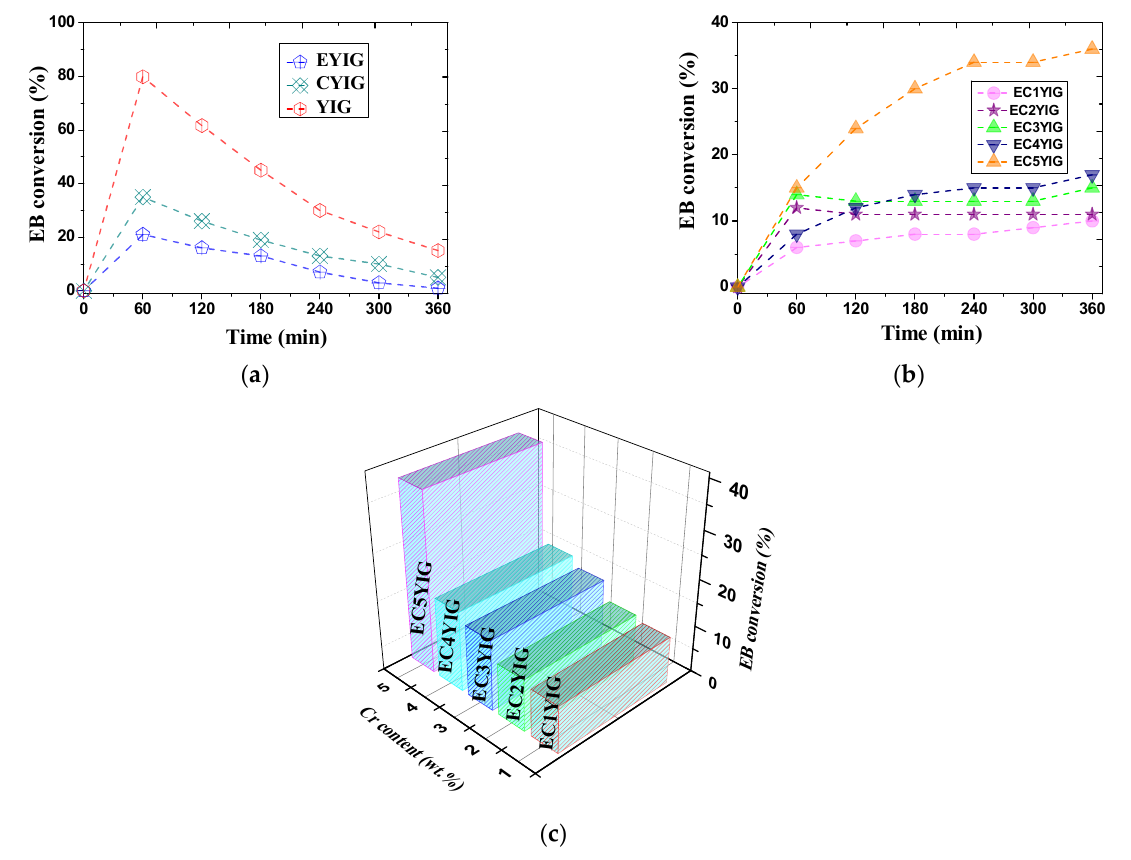
Figure 2. The reaction time-dependence conversion for yttrium iron garnet ferrites in the oxidation of ethylbenzene with H 2 O 2 : ( a ) YIG, CYIG and ECYIG catalysts ( b ) ECYIG series of garnets with distinct amounts of chromium ( c ) The relationship between EB conversions and Cr content present in the yttrium iron garnet ferrites in ethylbenzene oxidation with H 2 O 2 . Reaction conditions: EB to H 2 O 2 molar ratio of 1 using 1.3 mol of acetone as solvent, temperature of 50 °C and a catalyst mass of 50 mg within 360 min of reaction.